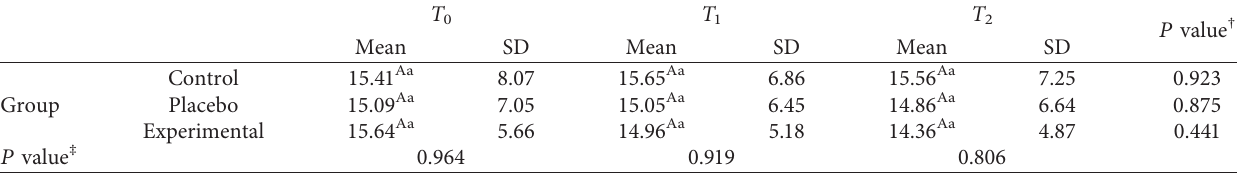
Table 3: Comparison of mean bleeding on probing (BOP %) from T 0 to T 2 in control, placebo, and experimental groups (mean ±